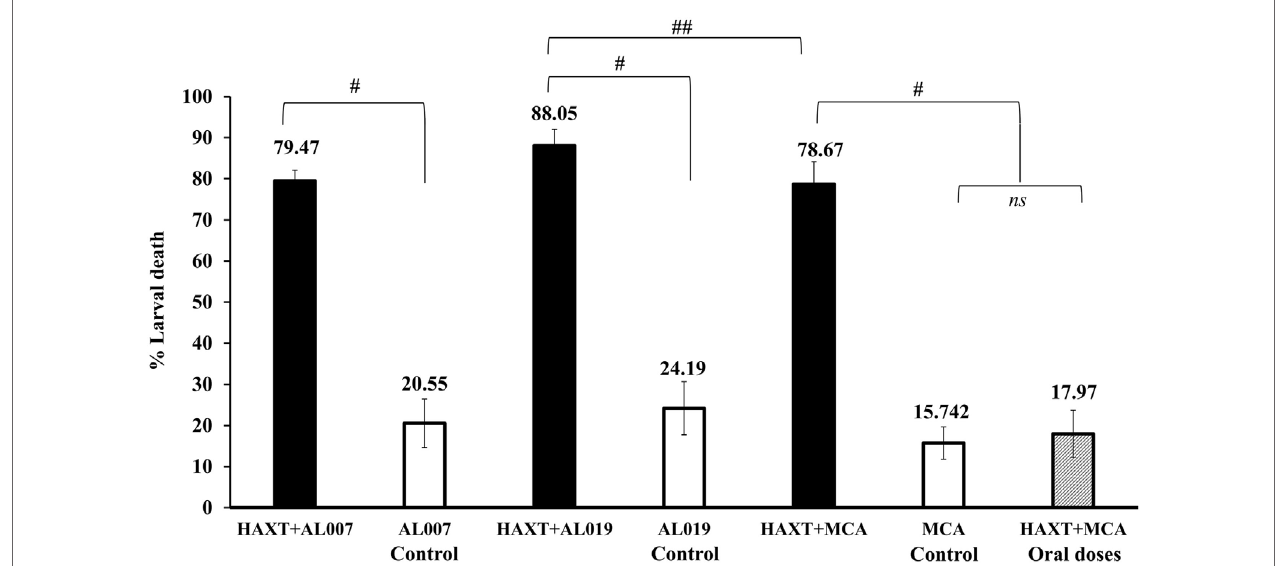
FigUre 4 | Vaccine-induced protection was calculated by percent larval death in immunized animals. Approximately, 20 live L3s were sealed in micropore chambers and surgically implanted in peritoneal cavity of mice. After 72 h, micropore chambers were taken out and L3s larvae were recovered and counted as live and dead worms to determine the percent larval death. Compared to adjuvant control groups, there was significant death of larva in vaccinated groups. Results showed that r Bm HAXT + AL019 immunized group showed maximum protection (88%), followed by 79.47 and 78.67% in rBm HAXT + AL007 and rBm HAXT + mannosylated chitosan, respectively. n = 5 mice per group, # p < 0.0001 and ## p < 0.05, ns = not significant compared to respective group as analyzed by Kruskal–Wallis test followed by Bonferroni correction for multiple